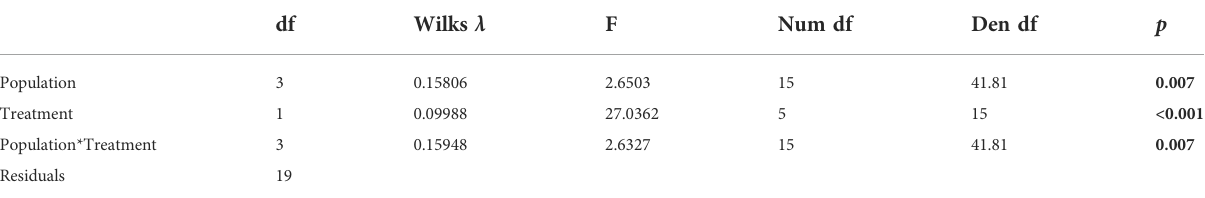
TABLE 4B Effect of population and treatment on gene expression responses to warming results of MANOVA to determine the effects of population and treatment on the expression of genes grouped together in Figures 3, 4. df Wilks λ